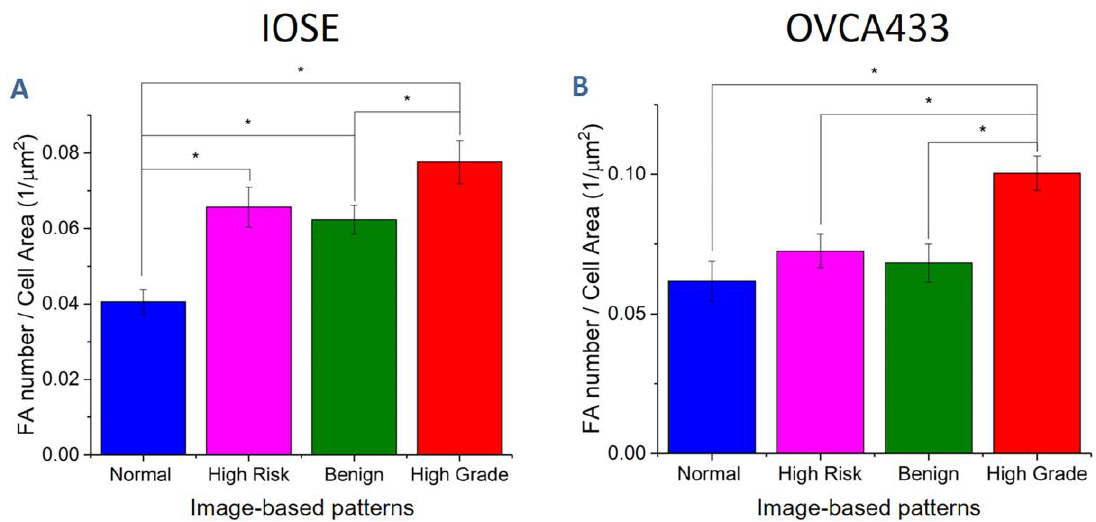
Figure 7. Focal adhesion density of IOSE ( A ) and OVCA433 ( B ) cells on image-based structures (* p < 0.05).